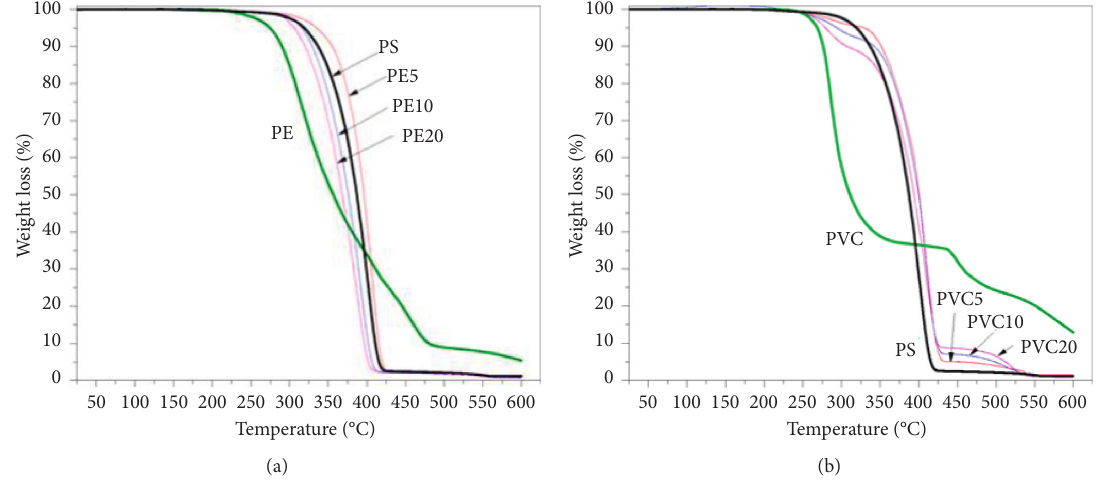
Figure 4: Thermogravimetric analysis of (a) PS-PE and (b) PS-PVC fibrous